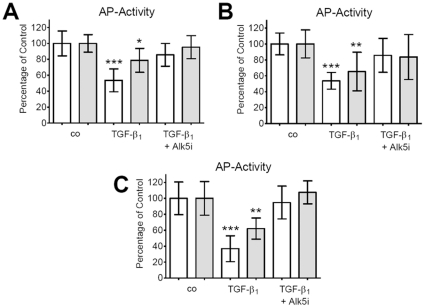
TGF-β1 dependent effects on AP activity by SB431542 are depending on time.Primary human osteoblasts stimulated with 5 ng/ml hra TGF-β1 in the presence or absence of 20 nM SB431542. After (A) 4, (B) 8 and (C) 12 days of continuous stimulation with TGF-β1 AP activity was measured and normalized to SRB staining for half of the cells (empty bars). The remaining cells were washed twice with DPBS and continued culturing for 8 days with basic culture medium. After the additional 8 days AP activity was measured in the same way (filled bars). Overall, with increasing time AP-activity was more and more reduced in the presence of TGF-β1. Supplementation with SB431542 was able to block the TGF-β1-dependent decrease of AP activity at all time-points. However, with increasing time of TGF-β1 pre-treatment, the so-called “rescue effect”, observed after the additional 8 days in basic culture medium, was reduced. Results are expressed as mean ± standard deviation (N = 4, n = 4). *p<0.05, **p<0.01, ***p<0.001 versus the corresponding untreated cells.